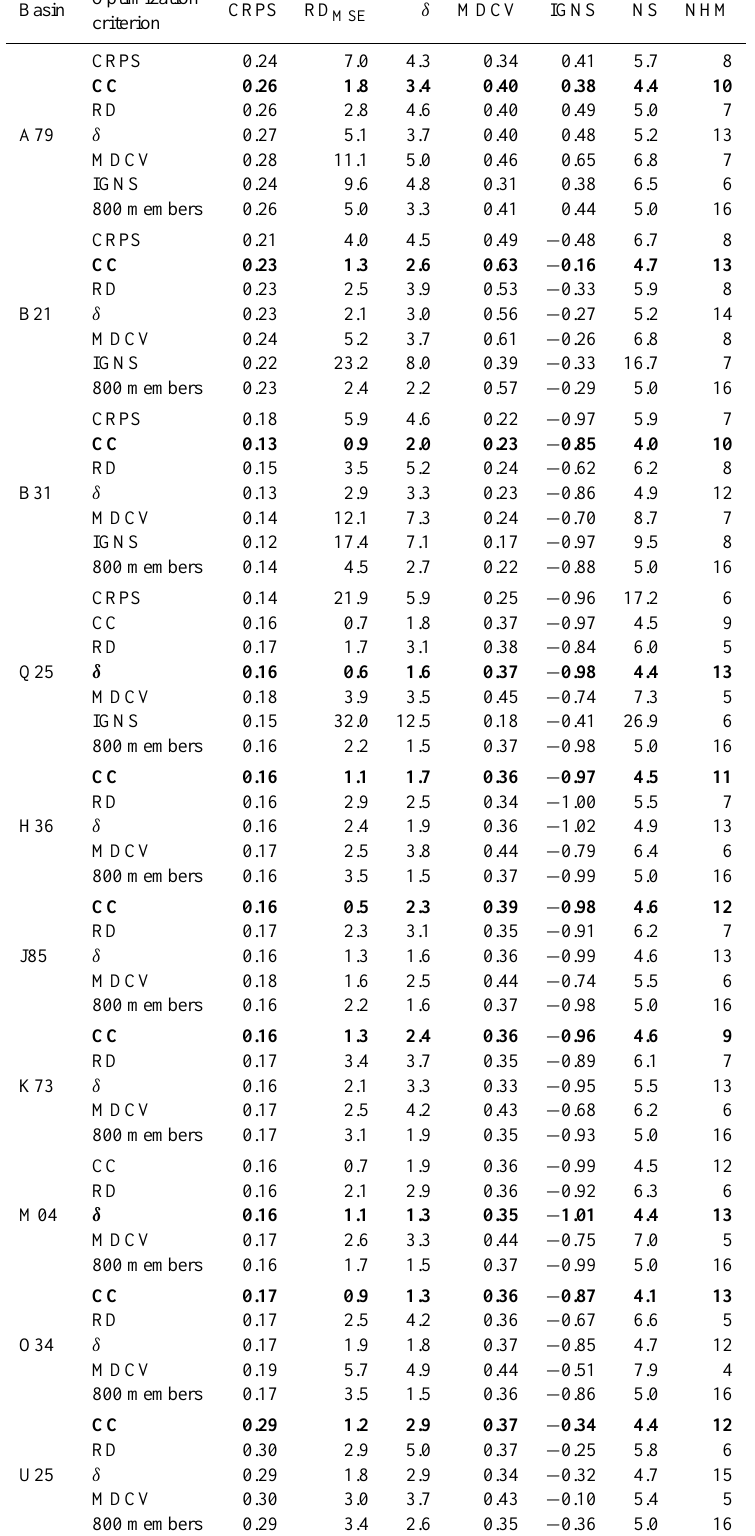
Table 6. Selection of 30 hydrological members based on different scores in all the basins or the lead time 9. NHM indicates the number of hydrological models participating in the